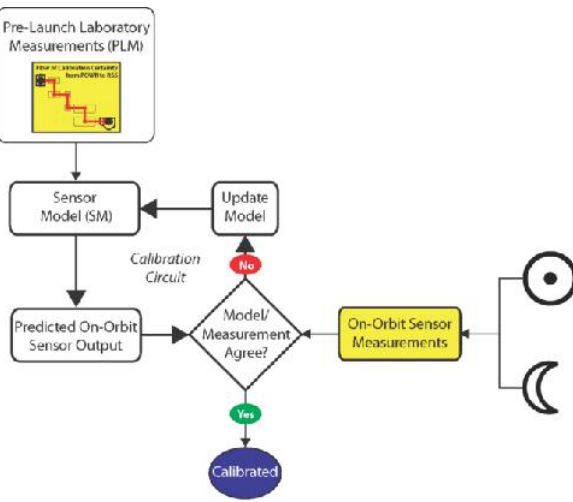
Figure 9. RS Calibration